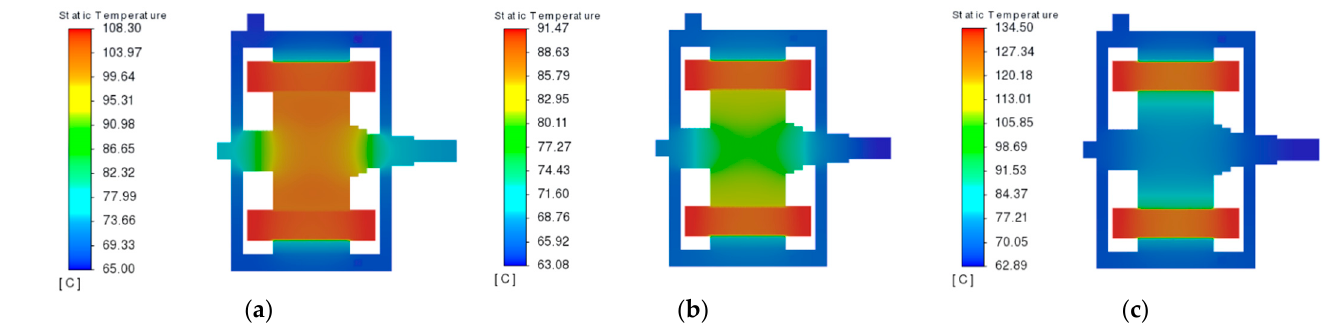
Figure 26. Temperature field solution results under three main operation conditions: ( a ) base speed conditions, ( b ) high-speed conditions, and ( c ) overload conditions.